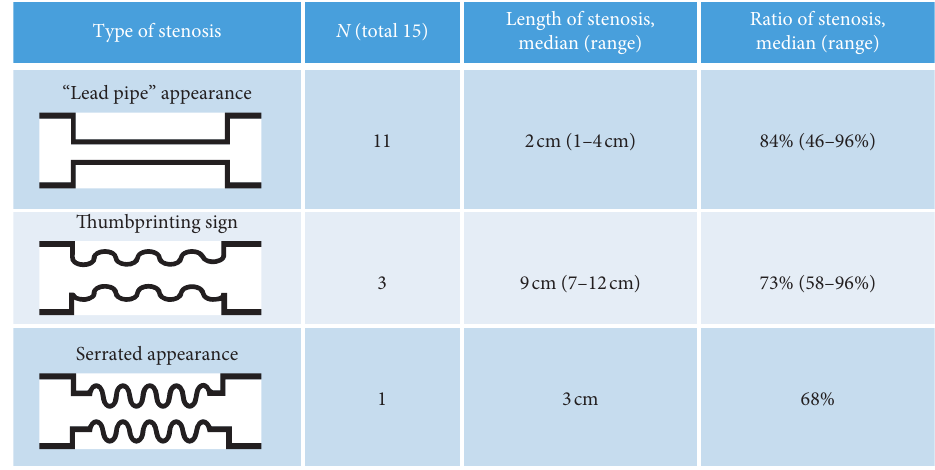
Figure 6: Types of positive findings at the stenosis site during small bowel enteroclysis. Table 4: New diagnostic criteria for ischemic